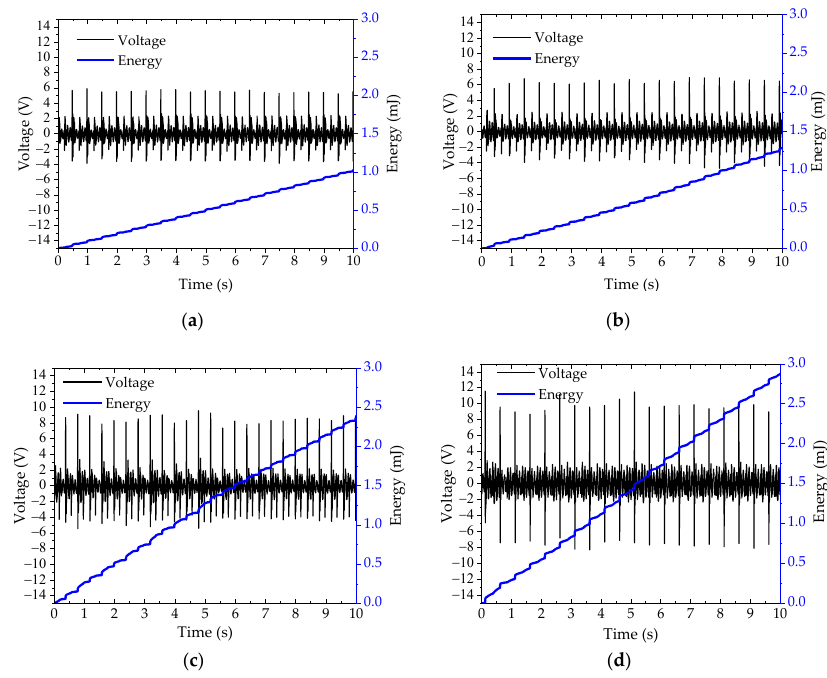
Figure 7. Output voltage and energy curve of PEH across the optimal load at 2 Hz with varying gap widths of ( a ) 1 mm, ( b ) 2 mm, ( c ) 3 mm, and ( d ) 4 mm.